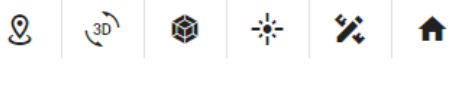
Figure 4. Editor user interface.